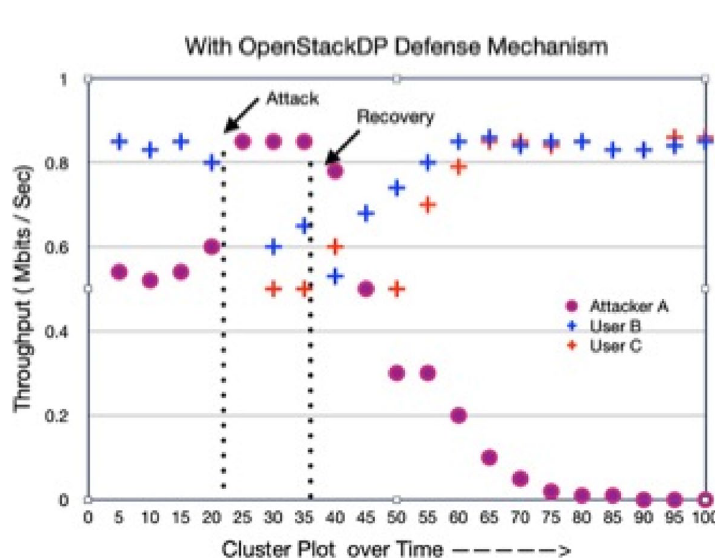
Fig. 35 Throughput Performance during Insider Attacks